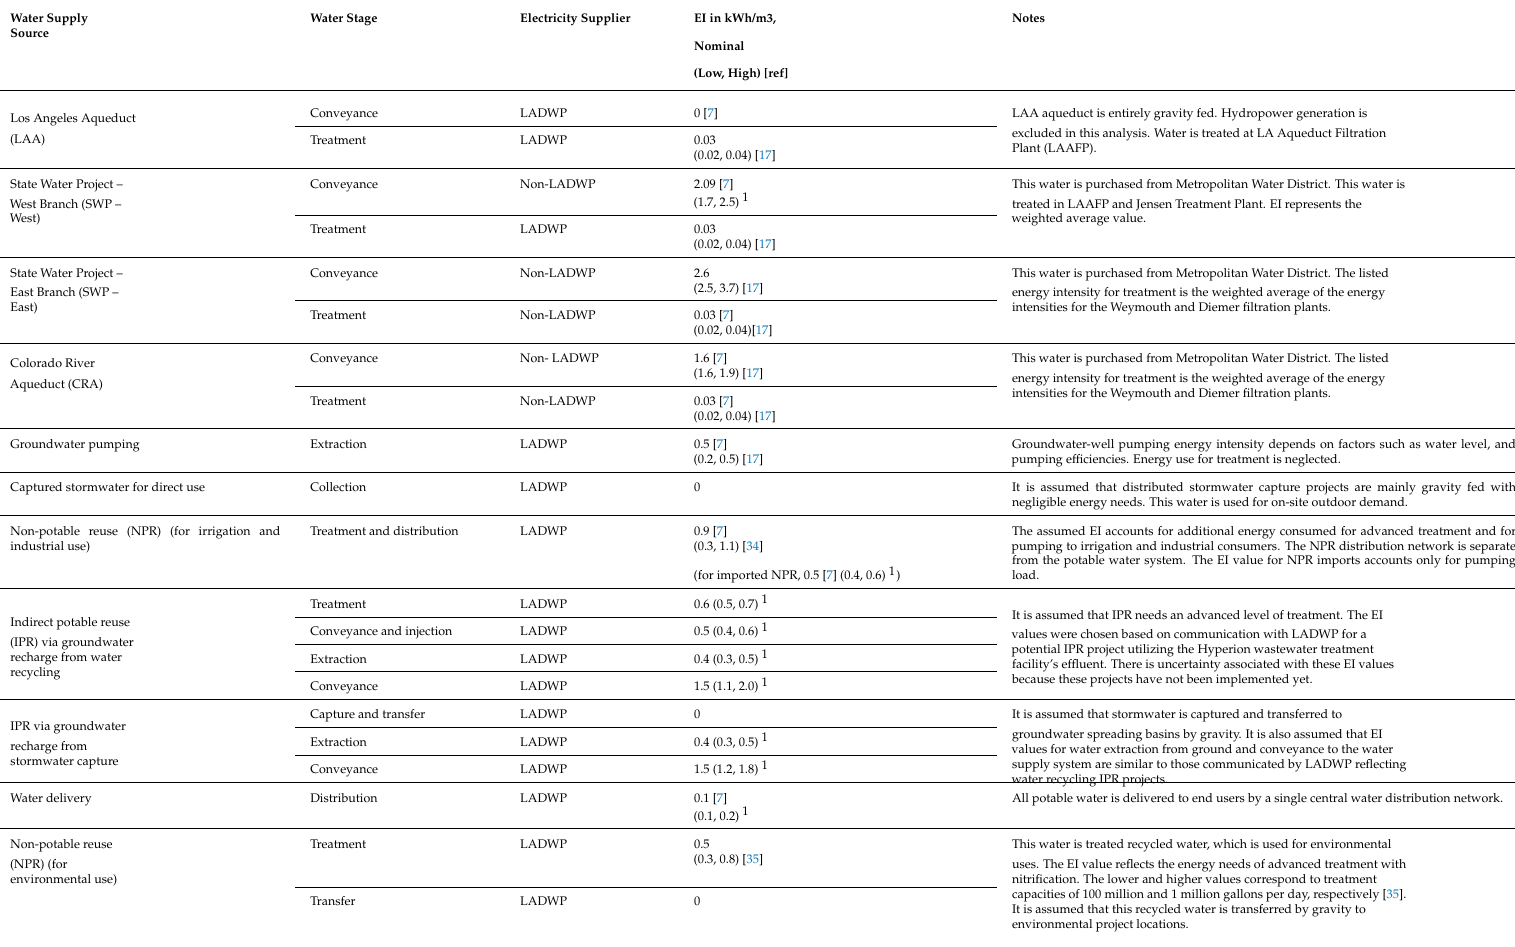
Table 1. Energy intensities of LADWP water supply sources and electricity serving